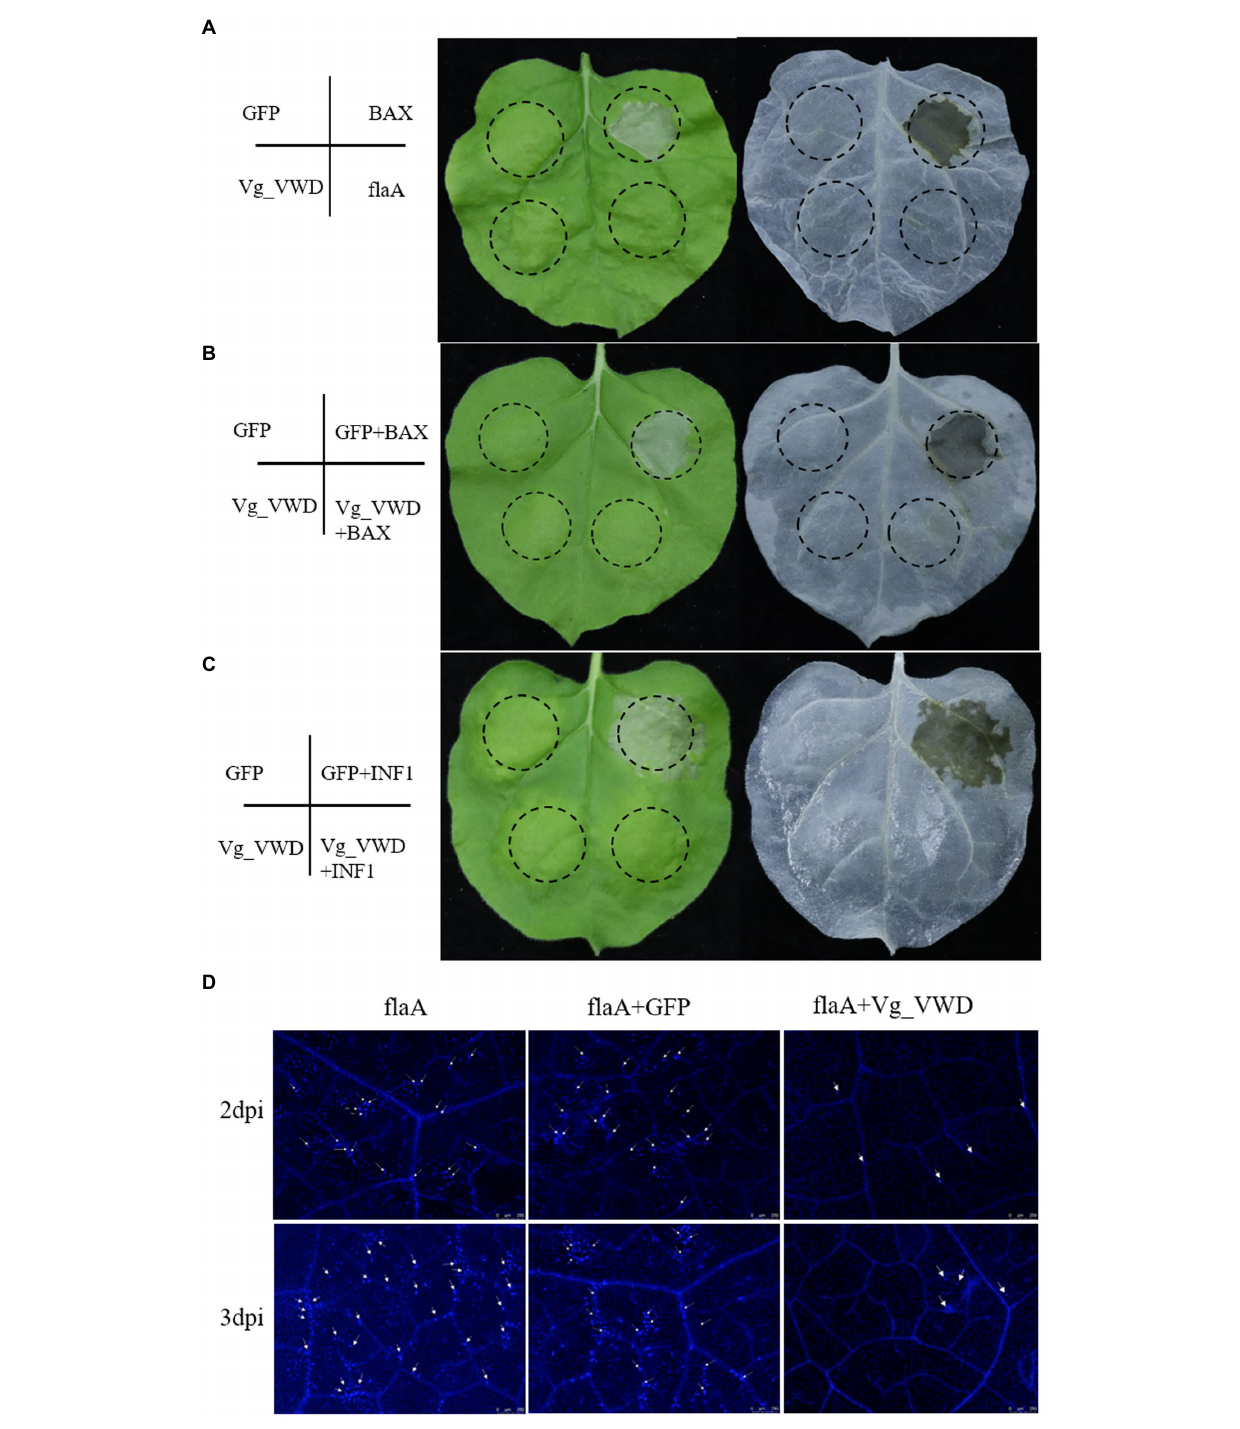
FIGURE 4 Transient expression of the Vg_VWD and flaA in N. benthamiana . (A) Symptoms on leaves with GFP , BAX , Vg_VWD, and flaA at 6 days postinoculation (dpi), where Vg_VWD and flaA postinoculation leaves showed no obvious symptoms. The Agrobacterium GV3101 (pJIC SA_Rep) strain harboring GFP , Vg_VWD , flaA, and BAX , resuspension with buffer, were infiltrated into the leaves of N. benthamiana . (B,C) The Vg_VWD suppressed the hypersensitive cell death triggered by BAX and INF1 in N. benthamiana infiltrated with GV3101 carrying GFP and Vg_VWD , and followed 24 h later with BAX or INF1 within the same regions (marked by the dashed circle). The leaves were harvested at 6 days after postinoculation of BAX and INF1 , followed by photography and decolorization with ethanol. (D) Vg_VWD suppressed accumulation of callose caused by flaA. Infiltrated leaves with flaA after 2 and 3 days were sampled for Aniline-blue staining and photographed. Scale bars represent 250 μ M. The experiment was repeated three times with at least 6 N. benthamiana leaves each